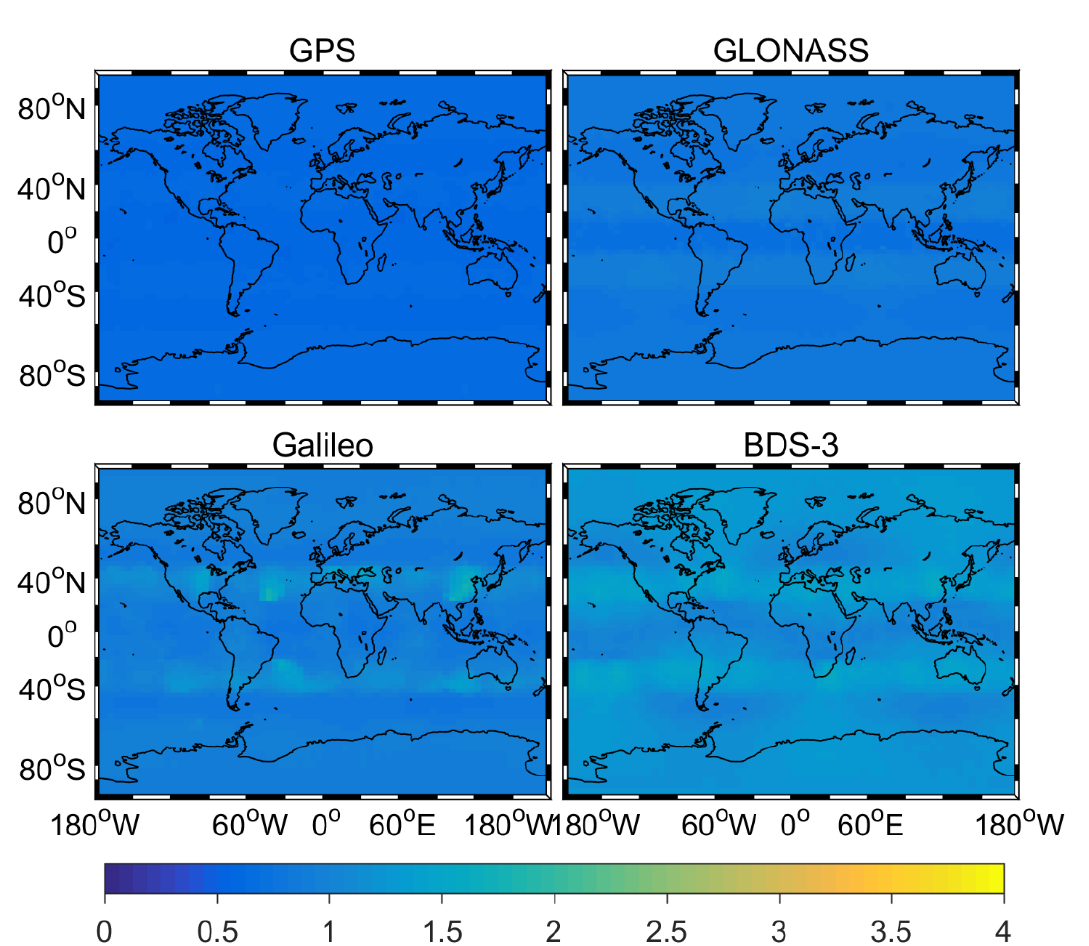
Figure 1. TDOP values of GPS, GLONASS, Galileo, and BDS-3.